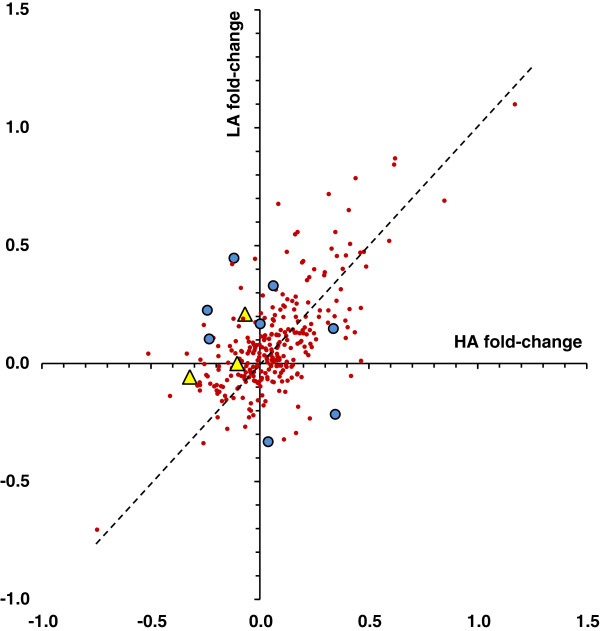
SNL nerve injury induced roughly equal up- and down-regulation (SNL-reg ) of miRNAs in DRGs of HA and LA rats (small red dots). Symbols to the right of, and above, the axes indicate nominal upregulation. The few miRNAs that were differentially regulated (diff-reg) are indicated by yellow triangles (rno-miR-30d-5p, rno-miR-125b-5p and rno-miR-379-5p) or large blue dots. Regulation was calculated using the subtraction method (SNL-sham/mean), HA_SNL1 excluded.